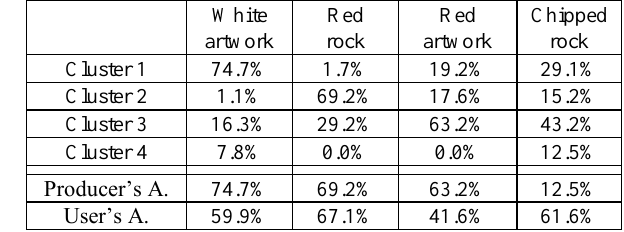
Table 5: Confusion matrix test 4.